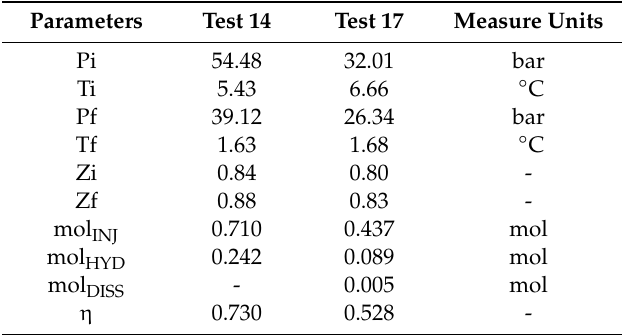
Table 8. Parameters related to Test 14 (with CH 4 ) and Test 17 (with CO 2 ).